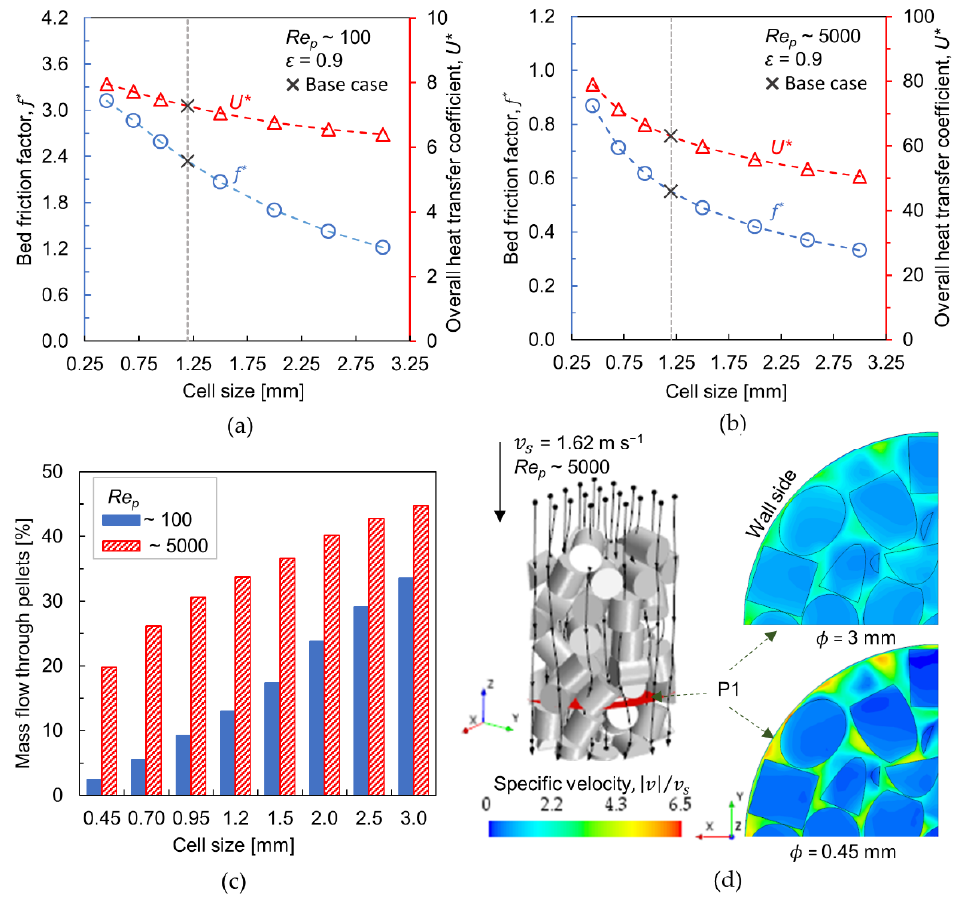
Figure 5. ( a , b ) Bed friction factor (left y -axis, circle markers) and overall heat transfer coefficient (right y -axis, triangle markers) versus cell size ( 𝜙 ) at Re p ~100 and 5000, respectively (Base case denotes, 𝜙 = 1.2 mm); ( c ) Percentage of mass flow through the foam pellets; ( d ) Normalized velocity contours at Re p ~5000 for cell sizes 3 mm and 0.45 mm (Velocity contours are displayed along the cross-sectional plane P1, Black lines running through the bed illustrate stream lines).